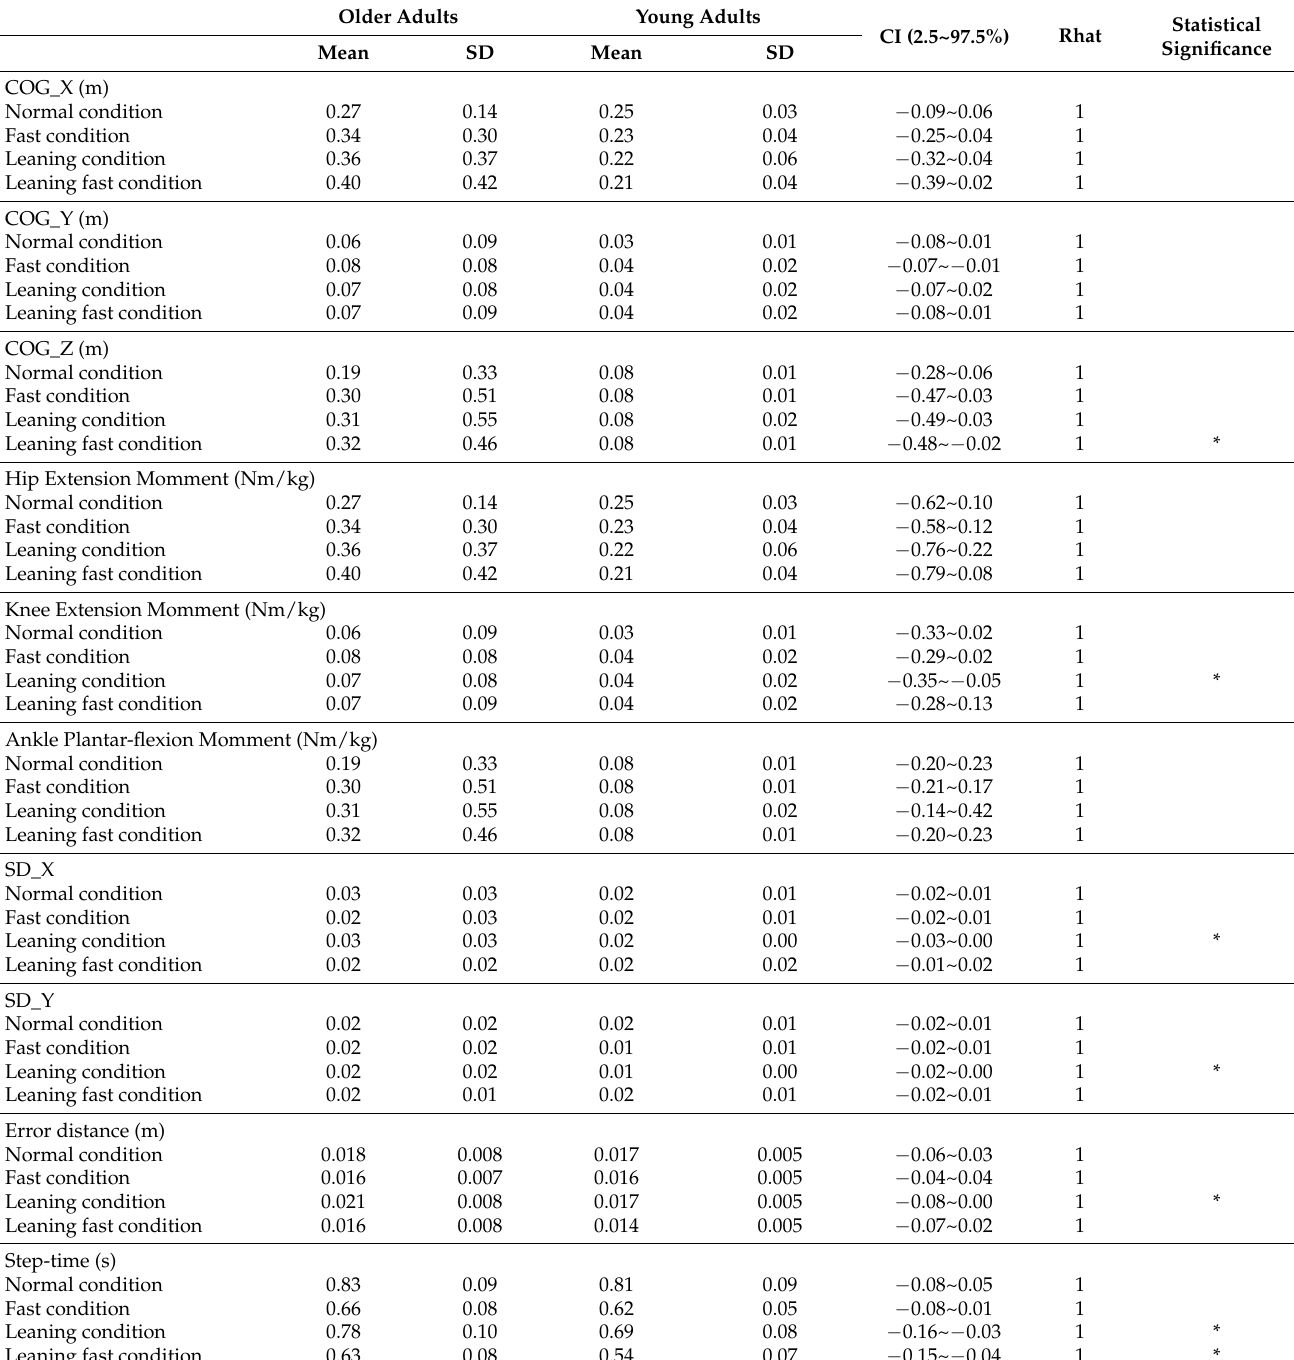
Table 2. The results of mean, standard deviation, 95% CI of the distribution of differences, and Rhat. Older Adults Young Adults CI (2.5~97.5%) Rhat